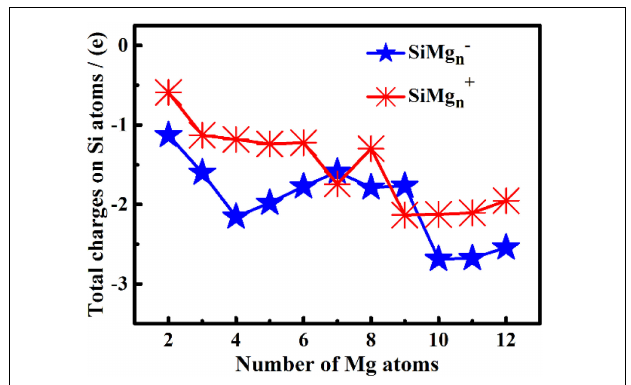
FIGURE 3 | The total charges on silicon atoms in the lowest-energy states of SiMg ± 1 n ( n = 2–12)